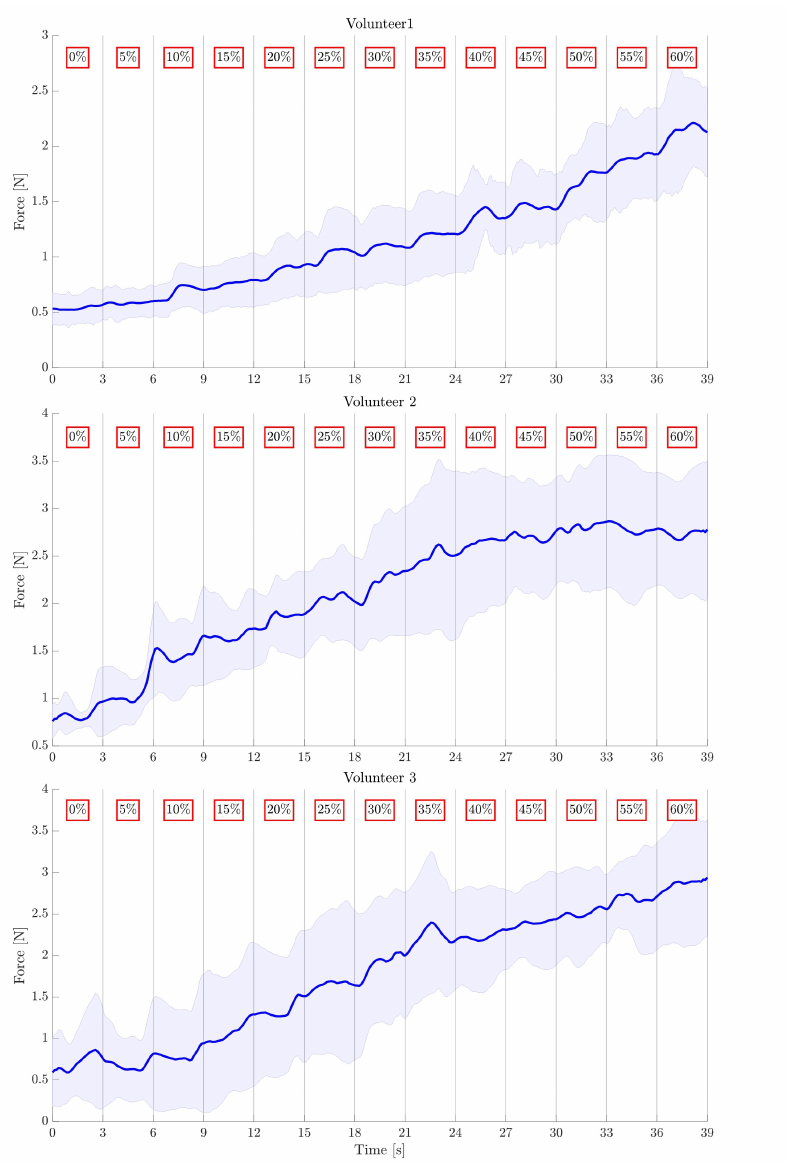
Figure 6. Average force increment (blue line) ± standard deviation (shaded area) for the 6 trials for each volunteer. The percentages in the red squares indicate the motors’ steps with respect to the maximum